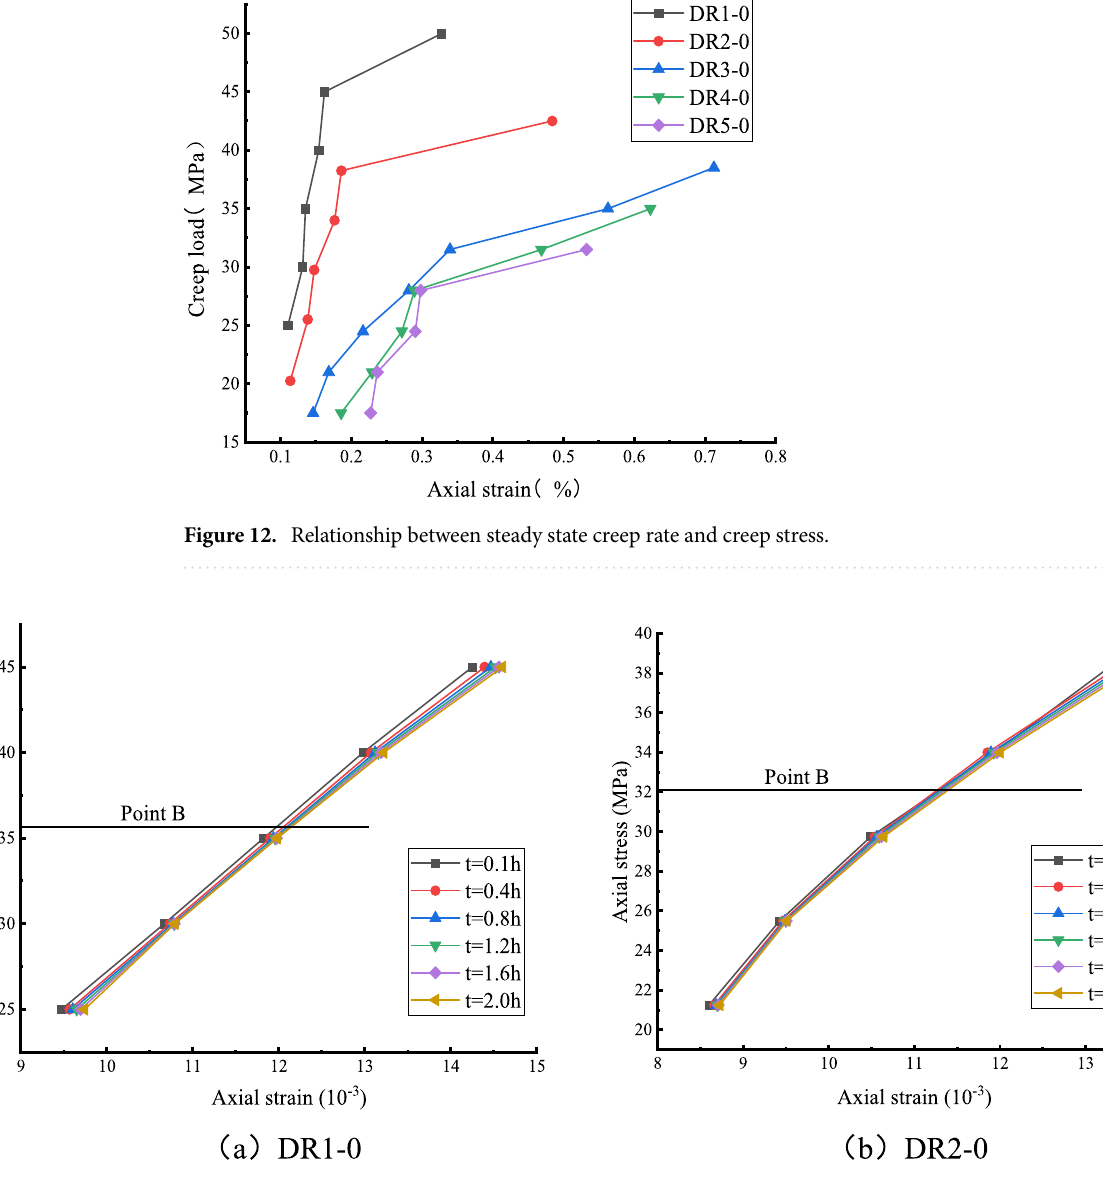
Figure 13. Isochronous stress–strain